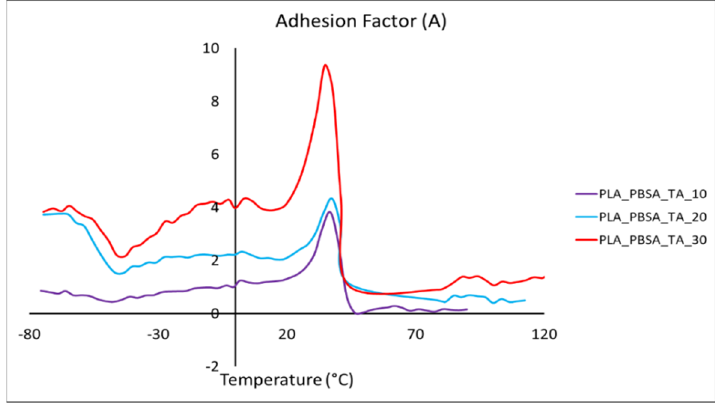
Figure 7. Adhesion factor vs. temperature for plasticized PLA/PBSA bran composites.